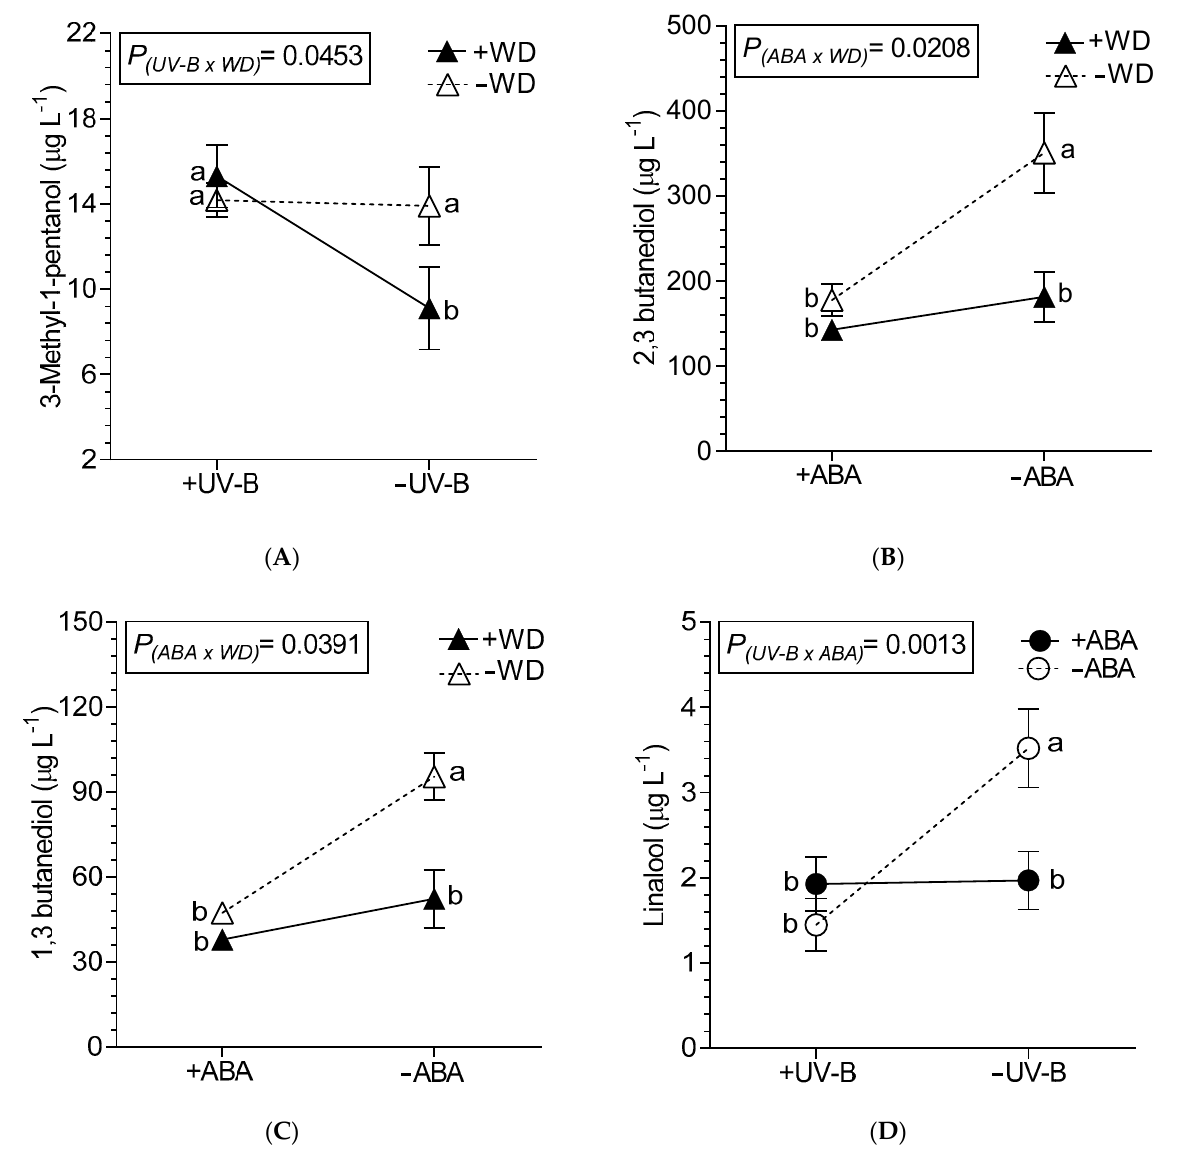
Figure 3. Interaction between UV-B and WD for 3-methyl-1-pentanol ( A ), between ABA and WD for 2,3 butanediol ( B ) and 1,3 butanediol ( C ), and between UV-B and ABA for linalool ( D ), determined in wines from Malbec plants exposed to combined UV-B, WD and ABA treatments. Values are means for each factor combination ±SEM (n = 3) and different letters indicate significant differences (Fisher’s LSD, p ≤ 0.05).